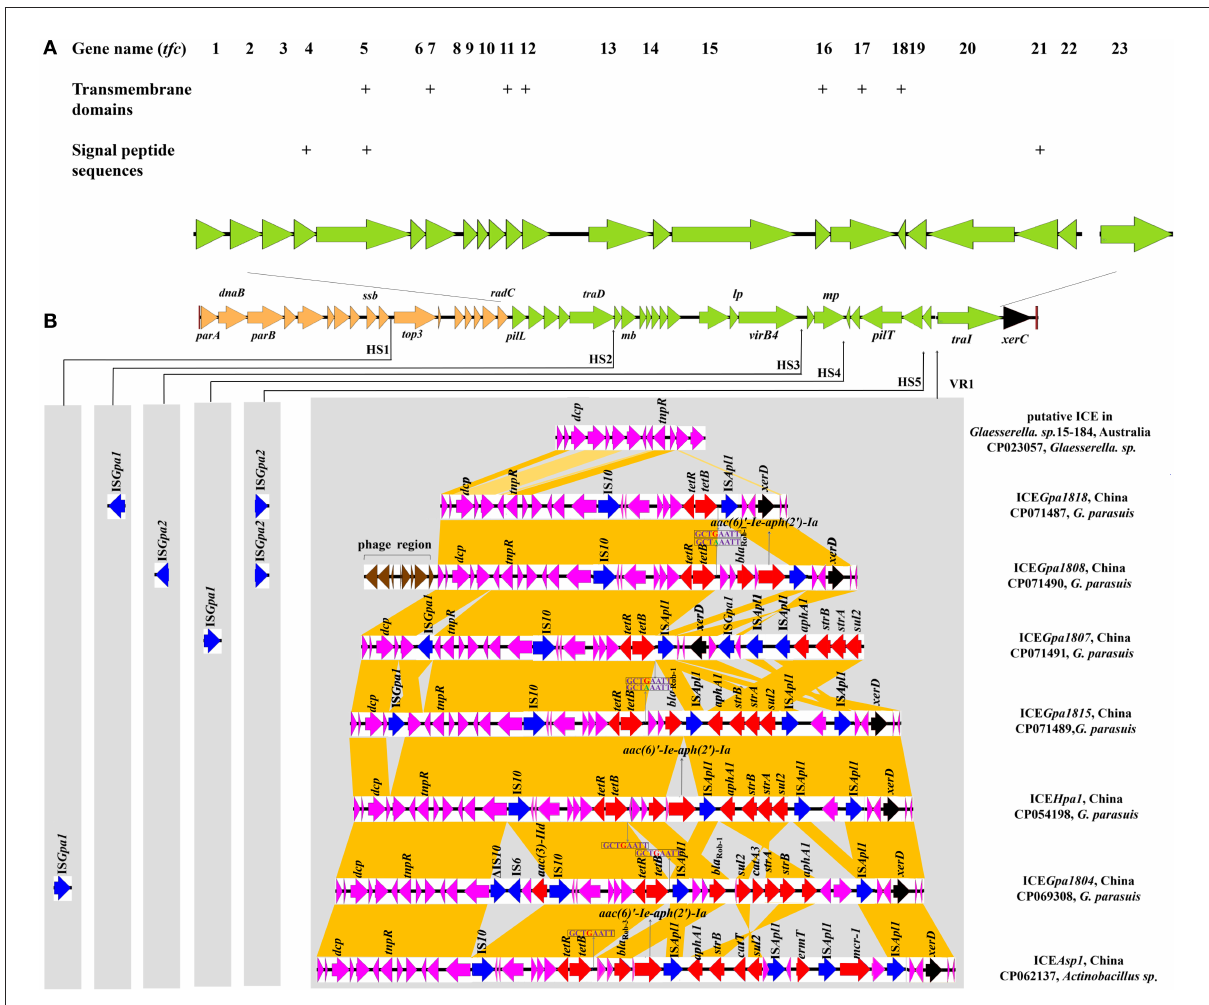
FIGURE1 (A) Schematic representation of eight ICE Hpa1 family ICEs and localization of the putative T4SS (green). This novel T4SS is encoded by 23 genes. Seven of the 23 ORFs from putative T4SS of the ICE Hpa1 have transmembrane helices (indicated by plus signs) and 3 of the 23 genes are predicted to contain signal peptide sequences (indicated by plus signs). (B) Structural comparison between eight ICEs from ICE Hpa1 family: the putative ICE in Glaesserella sp. 15-184 (CP023057), ICE Gpa1818 (CP071487), ICE Gpa1807 (CP071491), ICE Gpa1808 (CP071490), ICE Gpa1815 (CP071489), ICE Hpa1 (CP054198), ICE Gpa1804 (CP069308), and ICE Asp1 (CP062137). Thin arrows indicate the sites of insertion for hotspots (HS1-HS5) and variable region (VR1). The different genes are shown in different colors among these ICEs. The putative replication